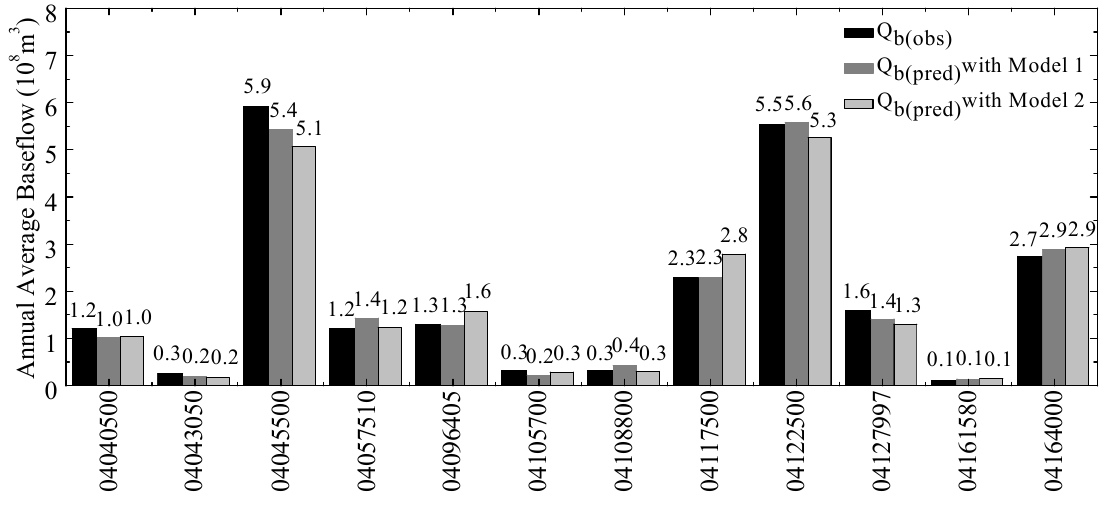
Figure 2. Predicted and observed average annual baseflow in watersheds used for model development (values on the bars represent average annual baseflow in the studied watersheds).